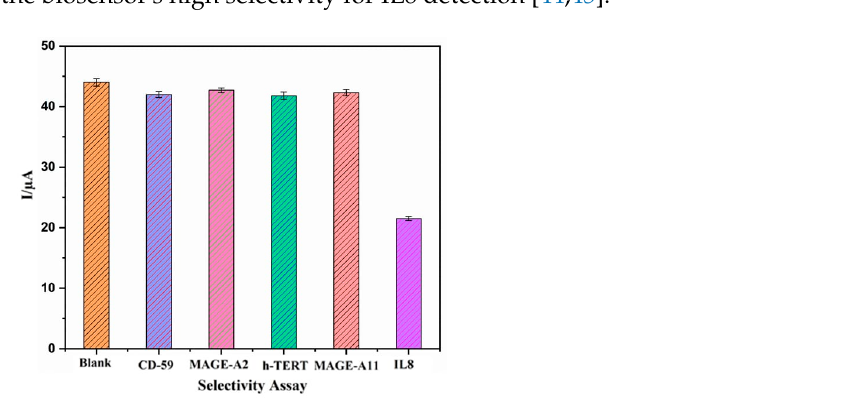
Figure 5. Bar graph showing the immunosensor response toward non-target analytes in comparison with response toward IL8.